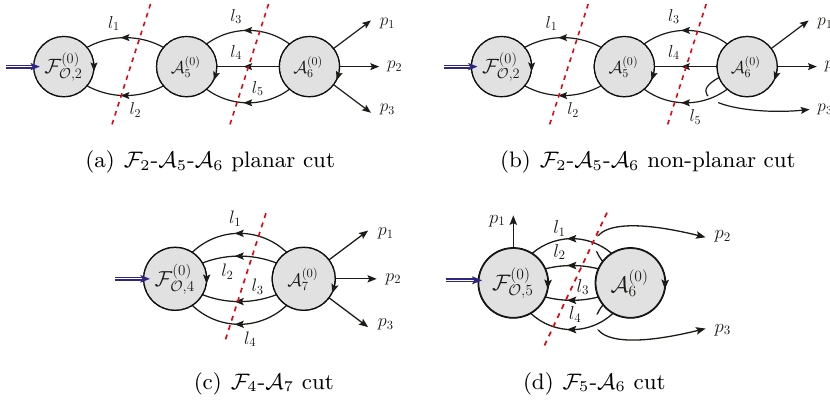
Figure 5. Quintuple and quadruple cuts for three-loop three-point form